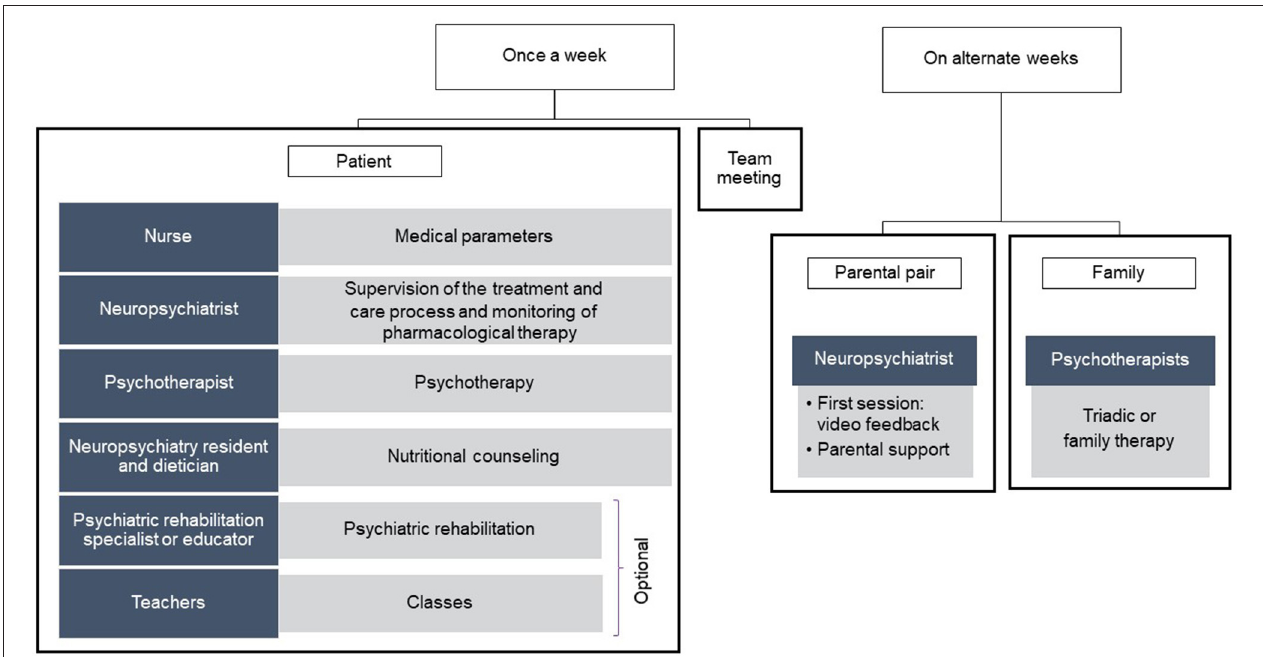
FIGURE 2 | Overview of the multi-disciplinary intervention.